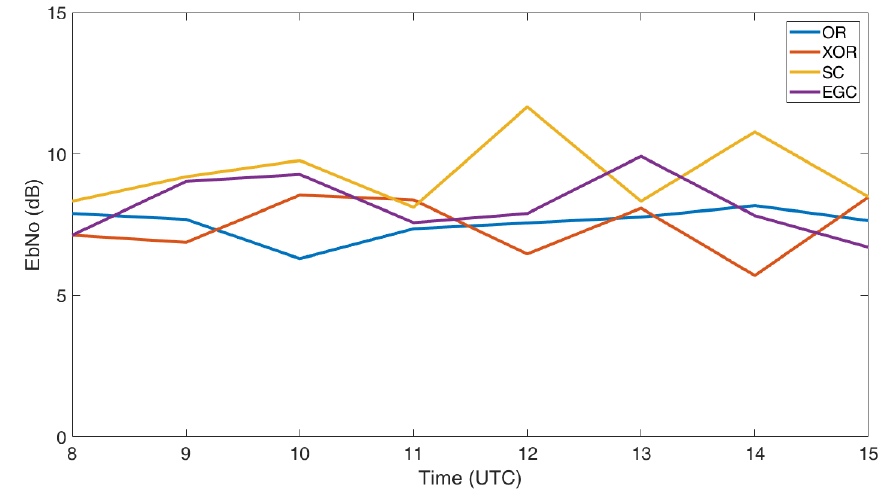
Figure 7. E b / N 0 vs Time for 4QAM at 50 Figure 7. E b /N 0 vs Time for 4QAM at 50 W.